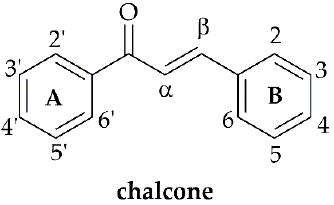
Figure 1. Structure of chalcone.